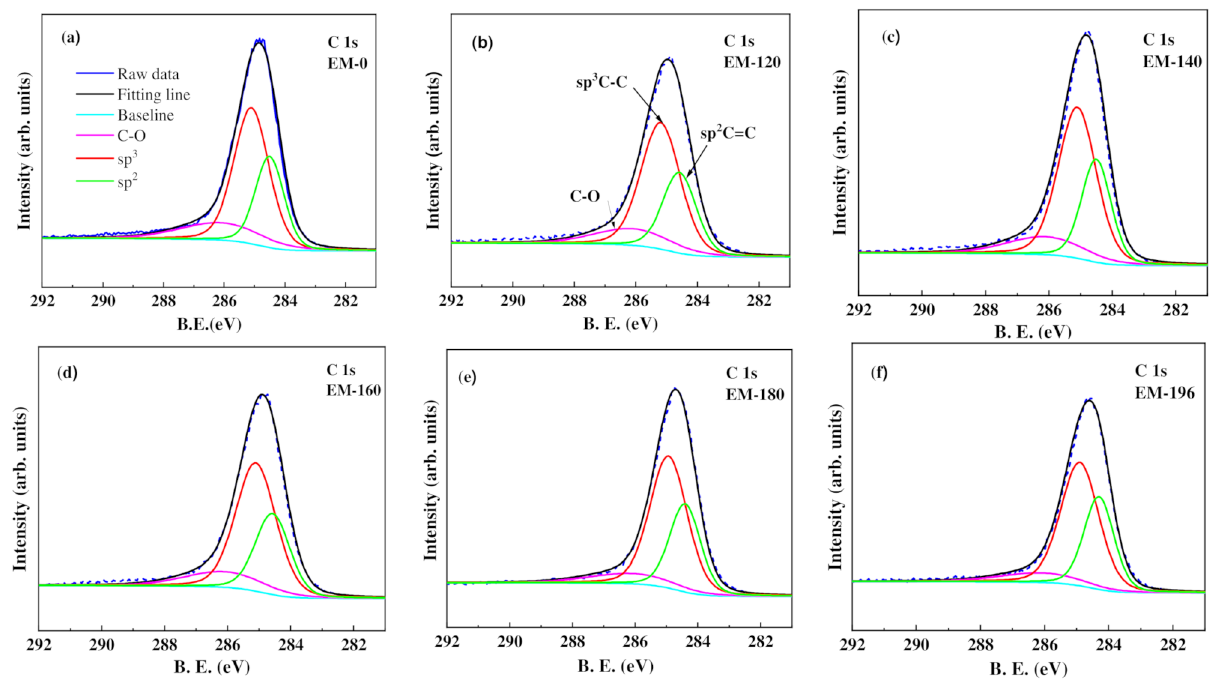
Figure 3. ( a – f ): C 1s XPS spectra of different